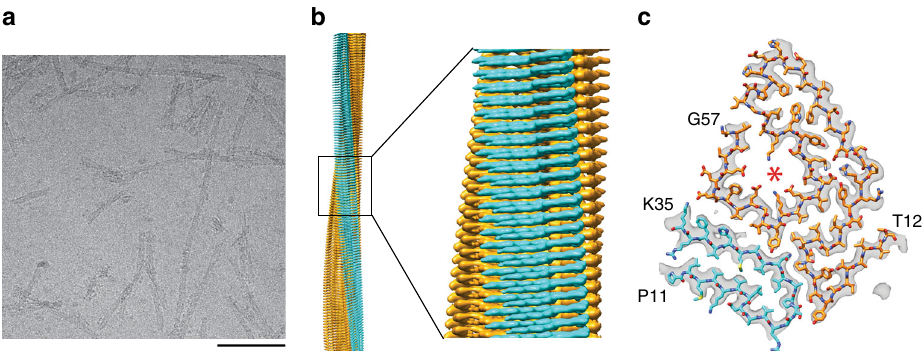
Fig. 1 Cryo-EM reconstruction of the ATTR amyloid fi bril. a Cryo-EM image of the extracted fi brils. Scale bar = 200 nm. b Side view of the reconstructed 3D map. N-terminal density: cyan; C-terminal density: orange. c Cross-sectional view of the reconstructed 3D map (grey), superimposed with a molecular model of the N-terminal (cyan) and C-terminal peptide segment (orange). Terminal amino acids are indicated in the fi gure. The internal cavity is marked with peptide bonds, including the fi ve X-proline bonds, are present as trans isomers.